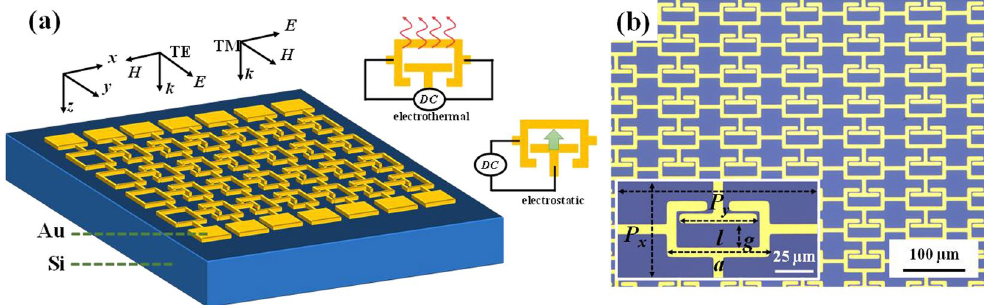
Figure 1. Schematic drawing and optical microscopy image of CLM. ( a ) 3D schematic drawing of CLM device and the coordinates of incident transverse electric (TE) and transverse magnetic (TM) waves, where E , H , and k are the electric field, magnetic field, and wave vector of electromagnetic wave, respectively. ( b ) Optical microscopy image of CLM device and the corresponding denotations of geometrical parameters are indicated in the inserted image of ( b